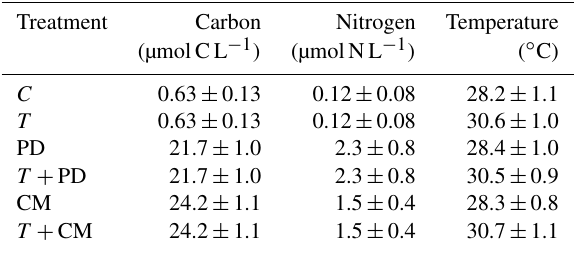
Table 1. Concentrations of carbon (µmolCL − 1 ) and nitrogen (µmolNL − 1 ) and measured temperature ( ◦ C) in the control and treatment chambers. Values correspond to the mean ±